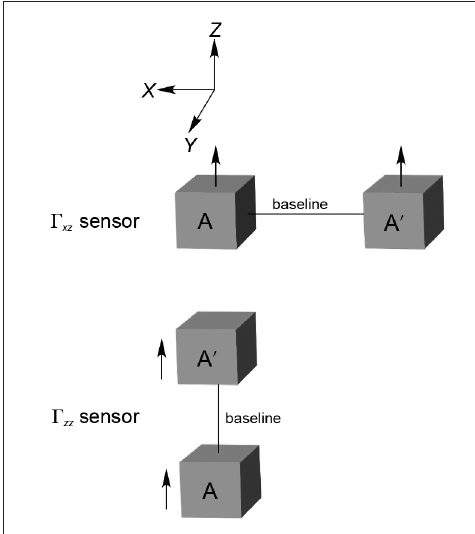
Fig. 1. Example basic configurations of a single- component gravity gradiometer. The geometric ar- rangement of the two linear accelerometers is